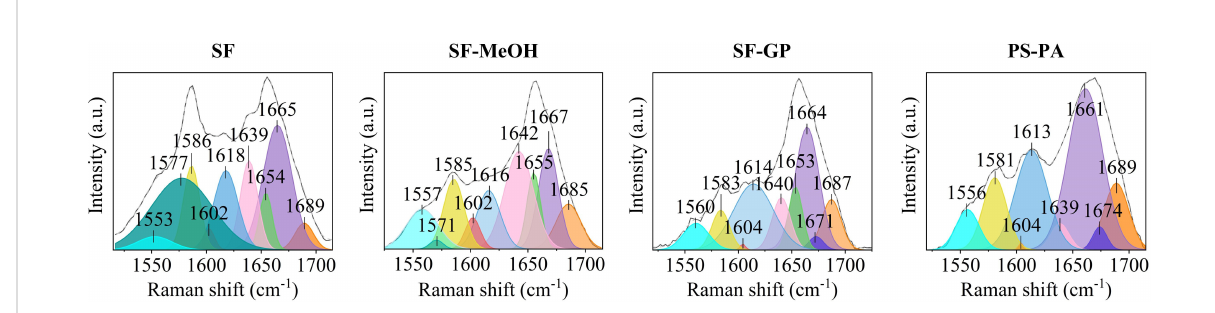
FIGURE 5 Fitting of the Raman spectra with peaks at 1,550-1,700 cm -1 obtained for different regions in the samples subjected to the four different preservation methods.